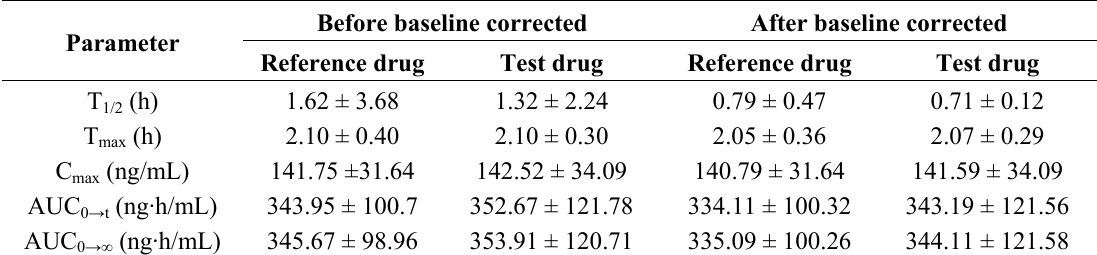
Table 4. The main pharmacokinetic parameters of ATRA after single oral dose of 20 mg to healthy volunteers (before and after baseline corrected).